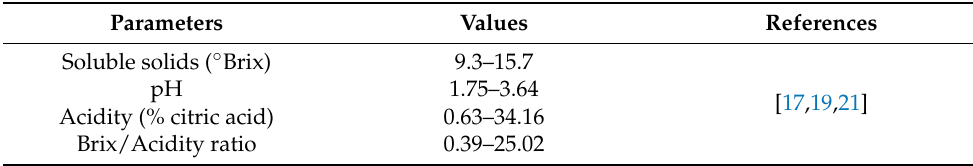
Table 3. Physicochemical characteristics of bacuri pulp ( Platonia insignis